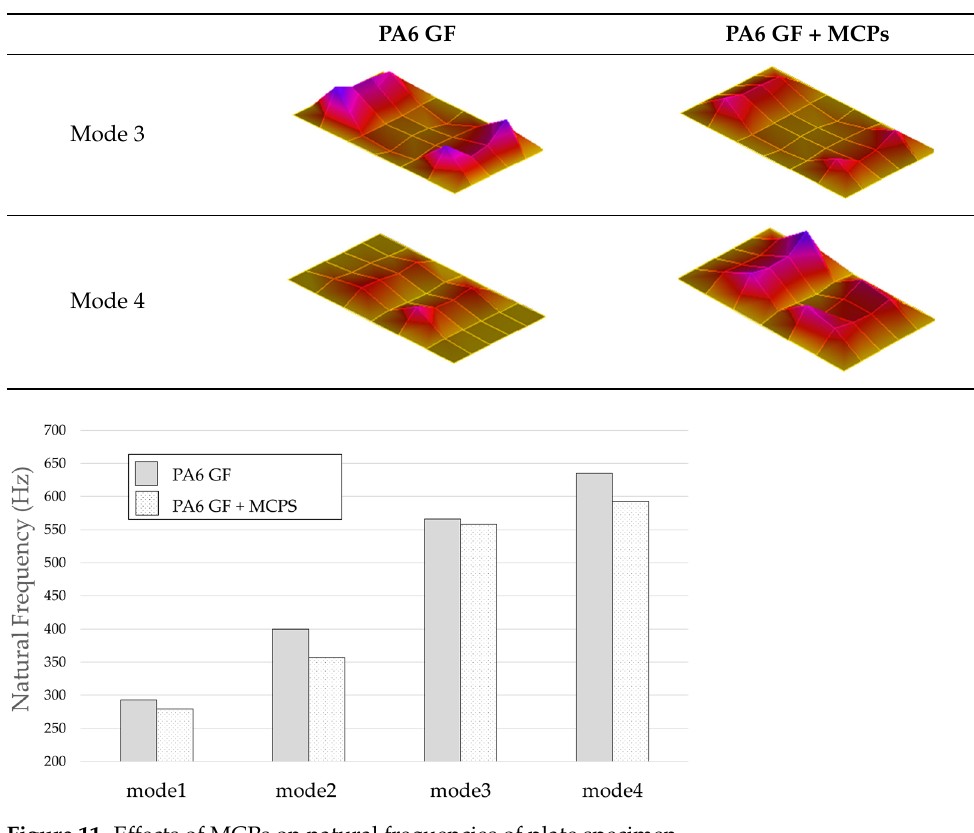
Figure 11. Effects of MCPs on natural frequencies of plate specimen.